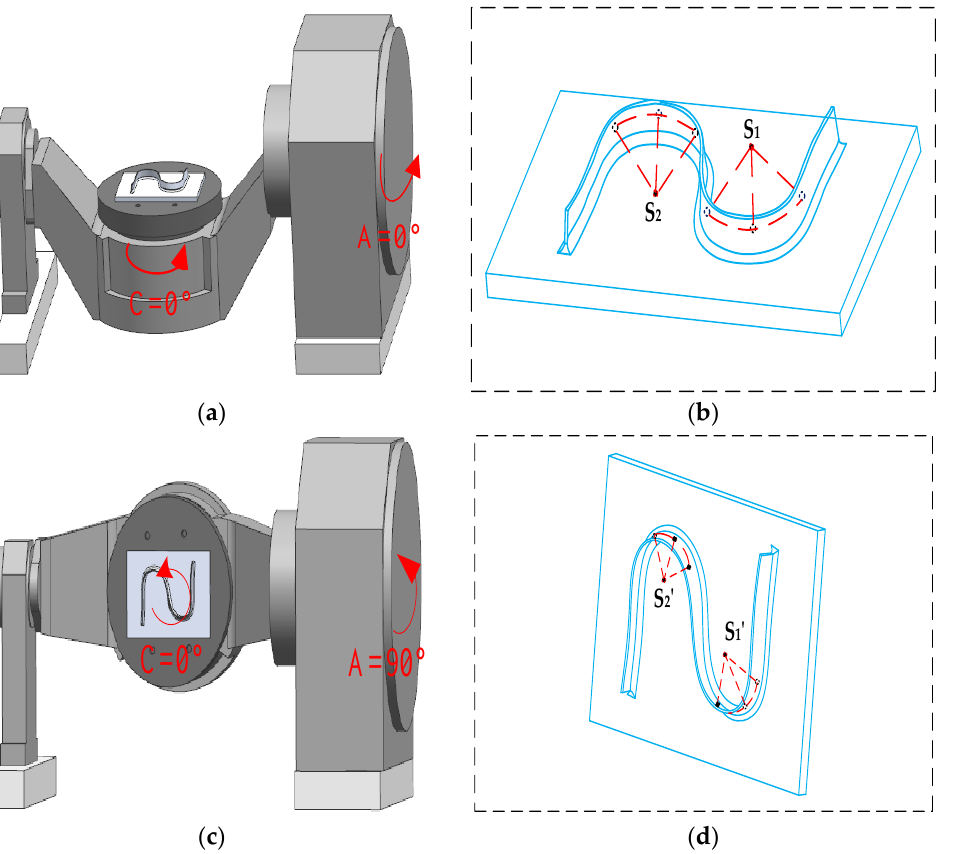
Figure 4. Schematic diagram of turntable position state when ( a ) a = 0 ◦ and ( c ) a = 90 ◦ , and marking diagram of measuring point position of S-shaped specimen at ( b ) a = 0 ◦ and ( d ) a = 90 ◦ . P 1 = [ xpypzp 1 ] T denotes the centre point coordinates of the A-axis in the actual coordinate system when there is an error. S 1 and S 1 (cid:48) are denote the centre point coordinates of the A-axis theoretical coordinate system when A = 0 ◦ and A = 90 ◦ , and S 2 is the same as S 1 . The coordinates of the centre point of the circle can be obtained by matrix